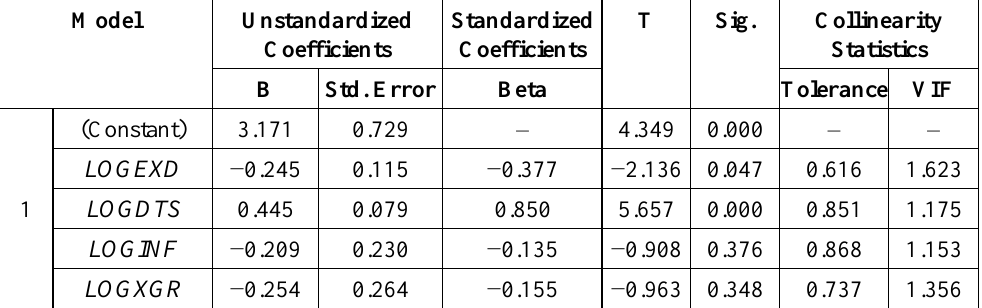
Table 3. Regression coefficients and correlations (Author’s computation, 2019) Model Unstandardized Coefficients